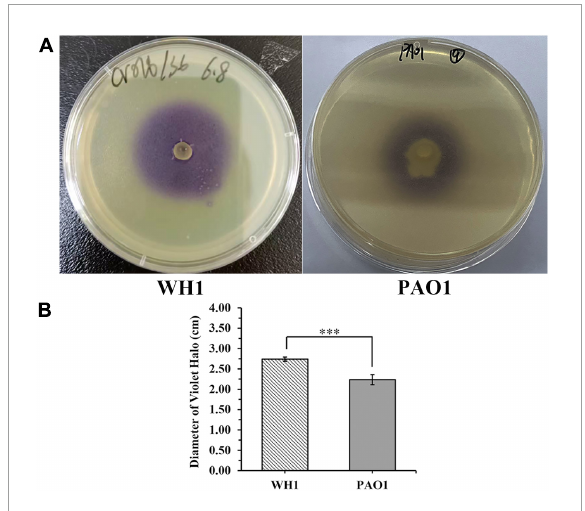
FIGURE7 Acylhomoserine lactones (AHLs) production by Dickeya zeae strain WH1 and Pseudomonas aeruginosa PAO1 at the same conditions. (A) Images are presentative of WH1 and PAO1 grown on Chromobacterium violaceum CV026 lawn for 24 h at 28 ◦ C; (B) quantification of AHLs production abilities, *** p <